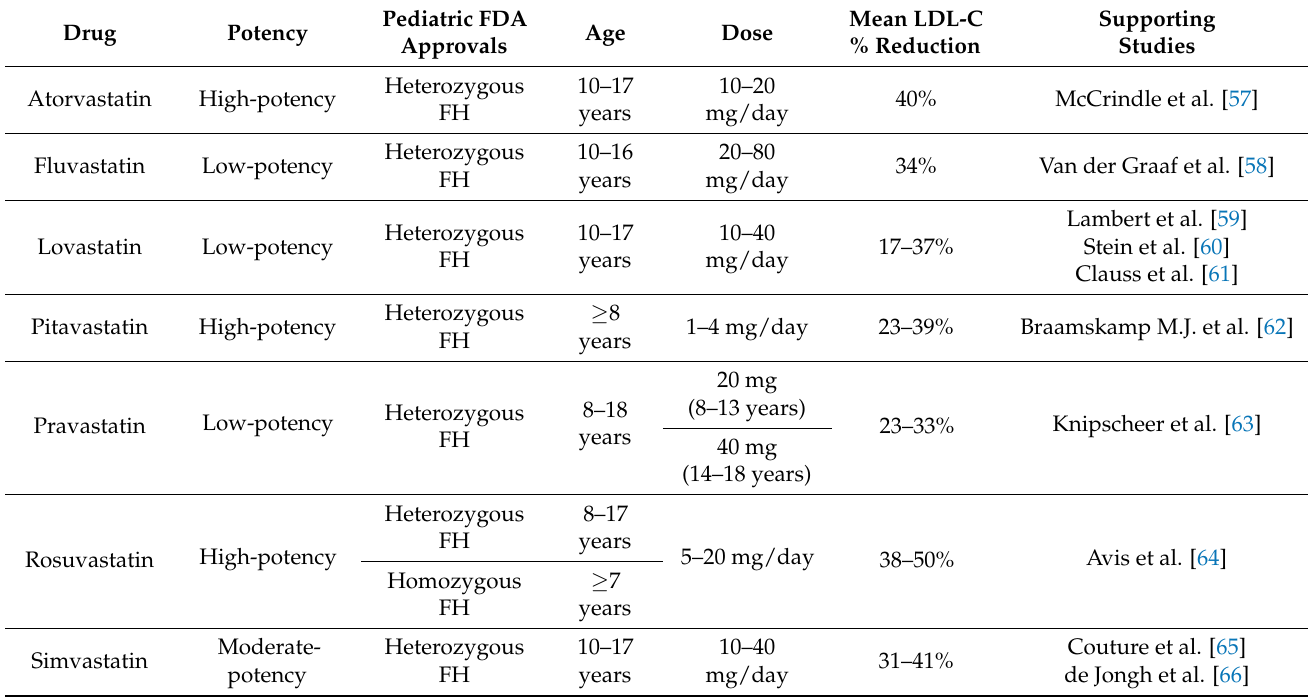
Table 1. Commercially available statins for children and